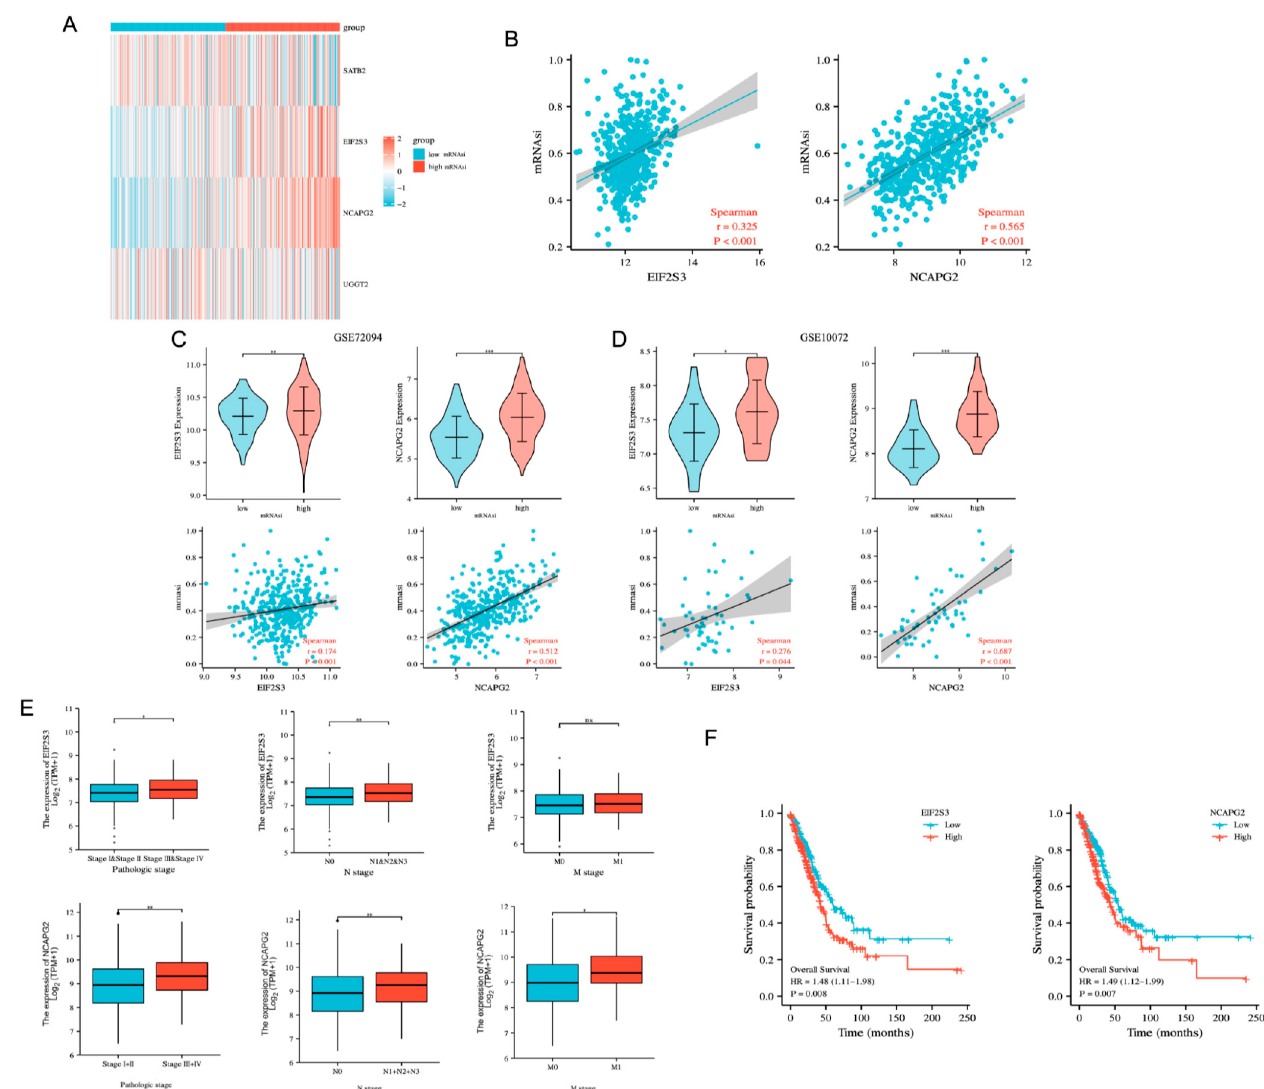
Figure 4. Relationship between the expression of NCAPG2 and EIF2S3 and stemness. ( A ) Heatmap showing gene expression in high and low mRNAsi groups. ( B ) Scatter plot showing the correlation between NCAPG2 and EIF2S3 and mRNAsi scores. ( C , D ) Validation of the association of NCAPG2 and EIF2S3 with stemness in LUAD from GSE10072 and GSE72094. ( E ) Relationship between NCAPG2, EIF2S3 expression, and clinical features of LUAD. ( F ) KM survival curve showing the OS of LUAD patients with high and low expression of NCAPG2 or EIF2S3 . KM: Kaplan–Meier; OS: overall survival. *** p < 0.001, ** p < 0.01, * p < 0.05, ns: no